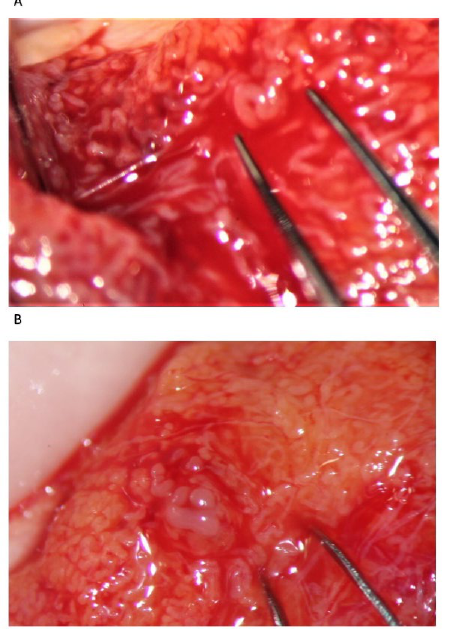
Figure 8. ( A ) An isolated dilated tubule; ( B ) a single dilated tubule surrounded by atrophic tu- bules.